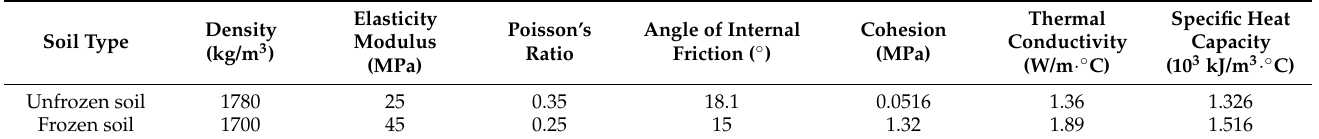
Table 1. Basic physical parameters of soils.